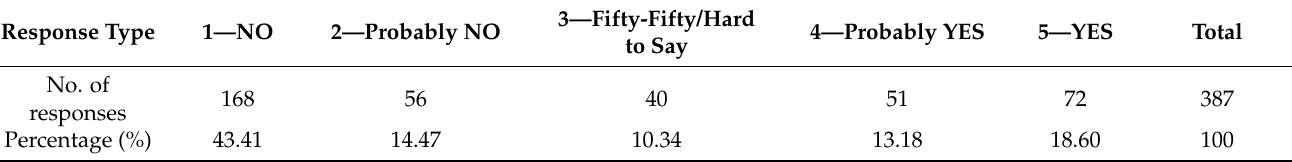
Table 8. Responses to the tenth question: Do you know what the NFT abbreviation means?